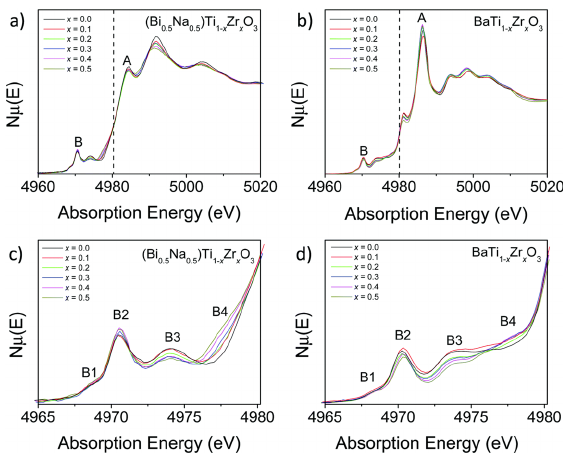
Figure 17. The Ti K ‐ edge XANES spectra of representative members of the ( a ) (Bi 0.5 Na 0.5 )Ti 1 − x Zr x O 3 ; and ( b ) BaTi 1 − x Zr x O 3 solid solutions. Major features of the Ti K ‐ edge pre ‐ edge region of the (Bi 0.5 Na 0.5 )Ti 1 − x Zr x O 3 and BaTi 1 − x Zr x O 3 solid solutions are highlighted in ( c ) and ( d ). Reproduced under